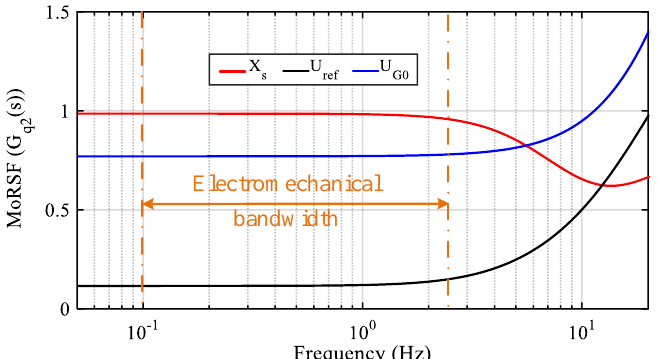
Figure 7. The magnitude of the relative sensitivity function (MoRSF) of G q 2 ( s ) with respect to operation parameters.